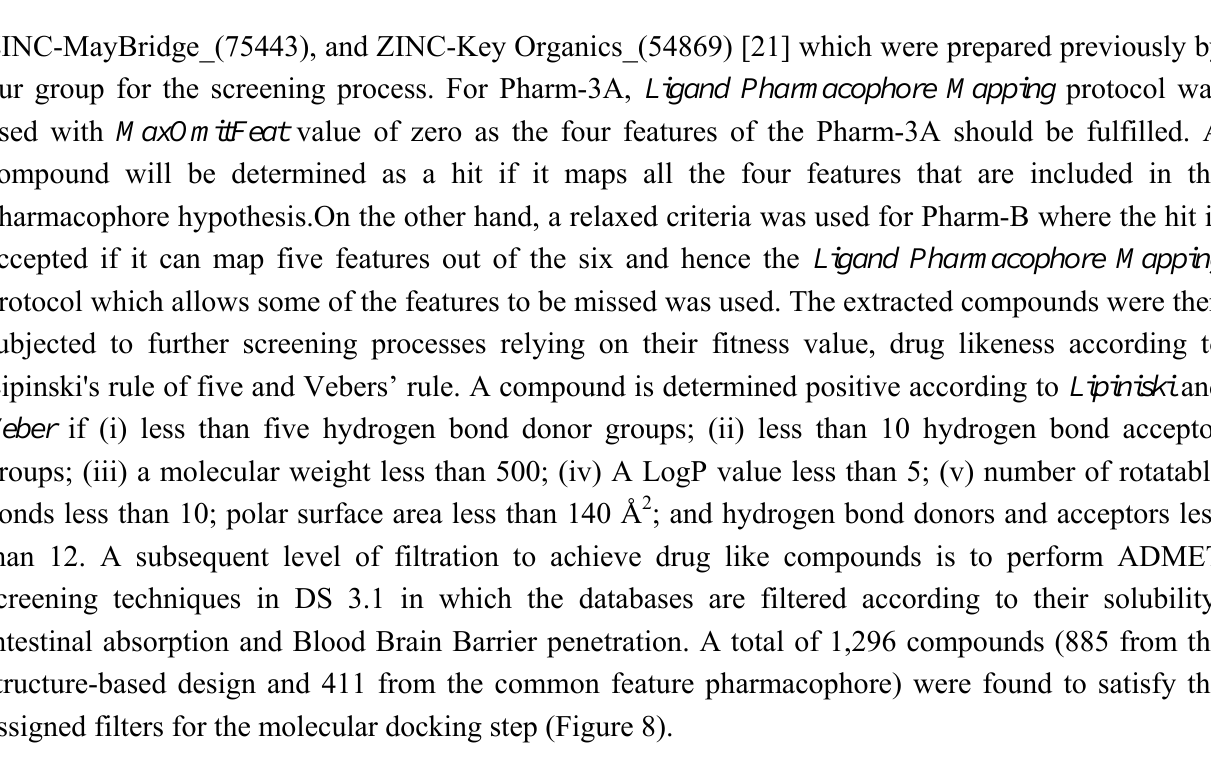
Figure 8. Database screening of three databases employing pharm-3A and pharm-B